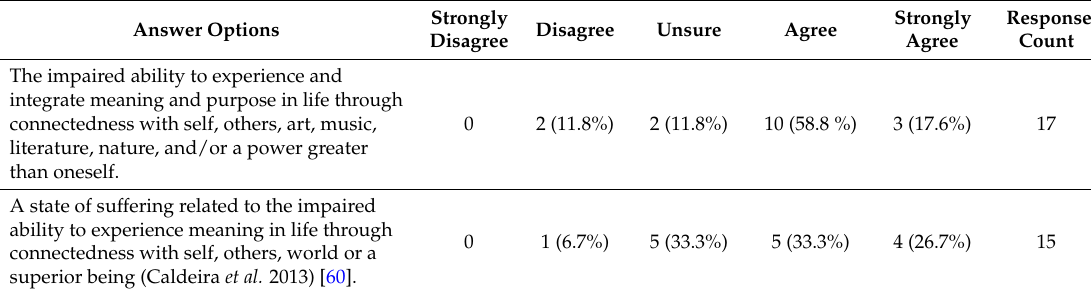
Table 6. Understandings of spiritual distress [60].